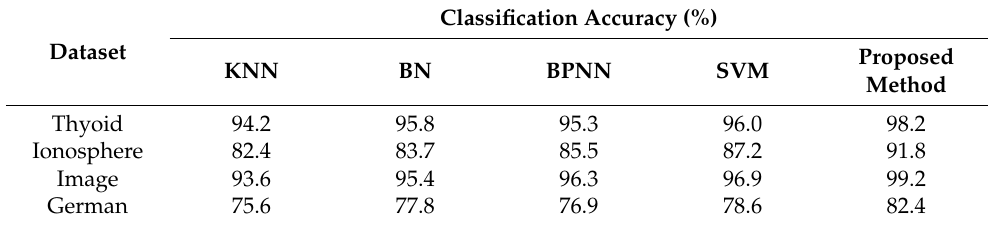
Table 1. Experimental accuracy on general datasets.